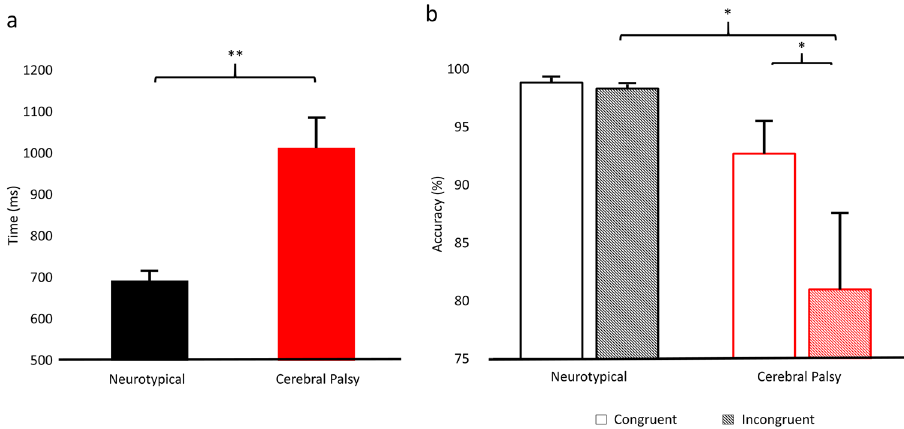
Figure 2. Reaction time and accuracy for neurotypical adolescents and adolescents with cerebral palsy. Repeated-measures analysis of variance of reaction time ( a ) and accuracy ( b ). Reaction time results revealed significant main effects of condition and group ( P < 0.001), but no interaction effect ( P = 0.4). The main effect of condition indicates slower reaction times for the incongruent condition compared to the congruent condition, while the main effect of group indicates that individuals with cerebral palsy responded slower than the neurotypical group. ( a ) Depicts the group effect ( P < 0.001). Accuracy results revealed main effects of condition ( P = 0.006), group ( P = 0.004), and an interaction effect ( P = 0.009). The main effect of condition reflected less accuracy for the incongruent compared to the congruent condition, while the main effect of group indicated that those with cerebral palsy were less accurate than the neurotypical adolescents. Post-hoc significance levels are displayed above the data, with error bars indicating the SEM. * P < 0.05, ** P <